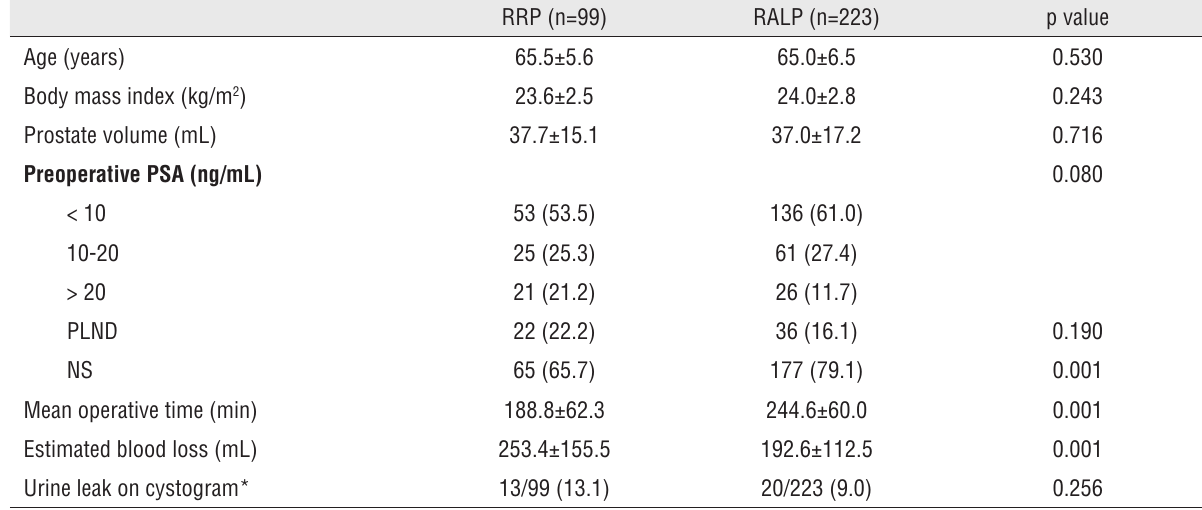
Table 1 - Demographic data & Operative parameter.